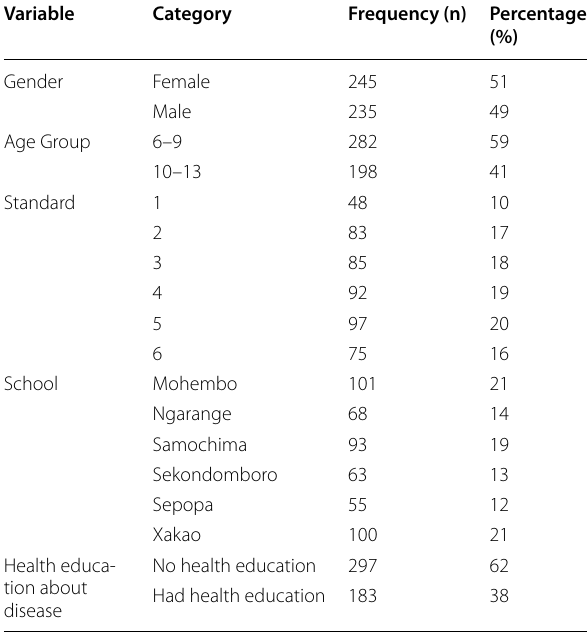
Table 2 Respondents` socio‑demographic